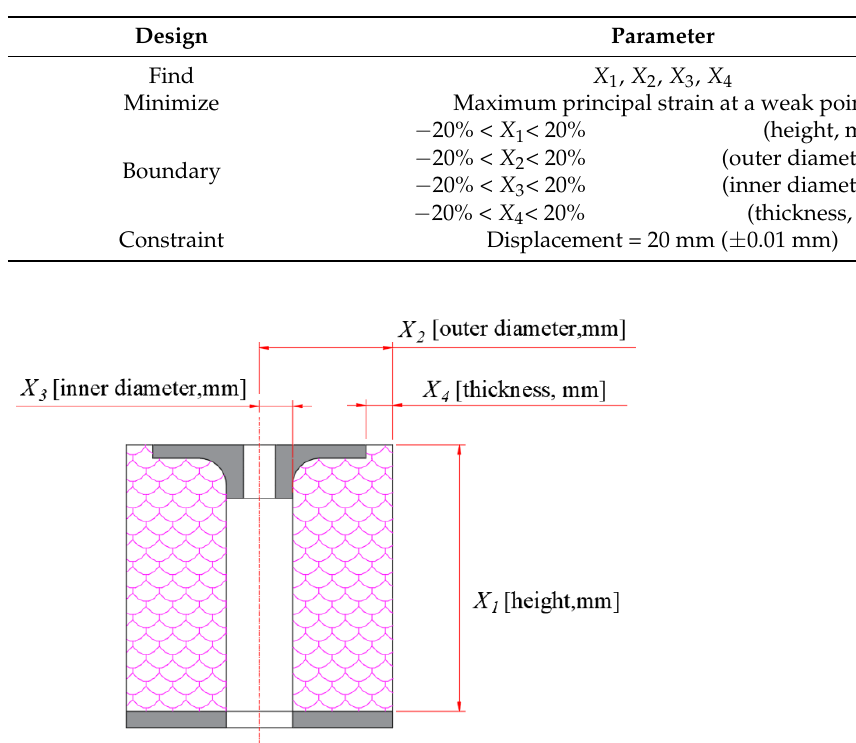
Table 4. Technical requirements of polyurethane spring.